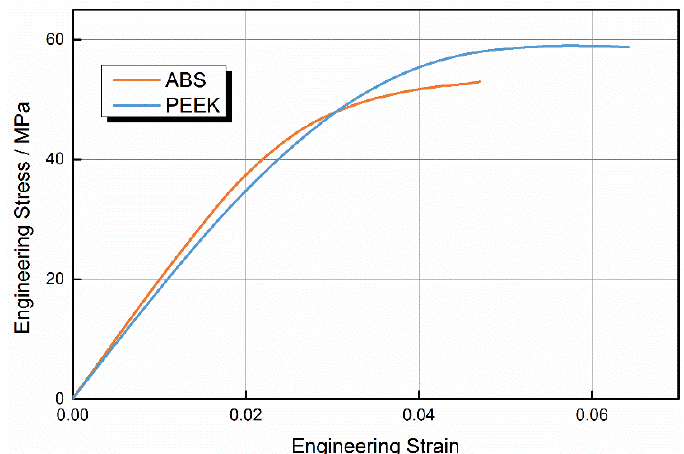
Figure 11. Bending stress-strain curves of acrylonitrile butadiene styrene (ABS) and polyether-ether-ketone (PEEK).